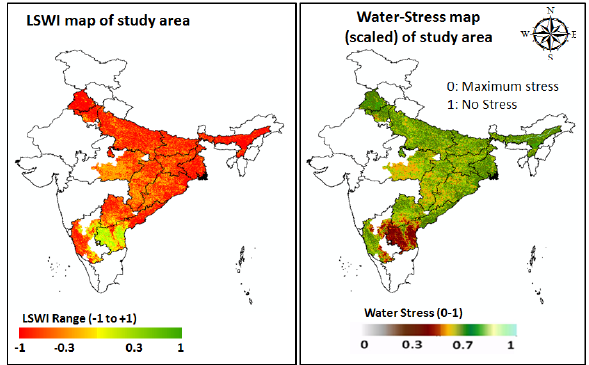
Figure 5: LSWI & Water Stress map of study area during 13-20 Aug, 2018 (1: No stress; 0: Maximum stress) Average temperature stress over a period of 8 days in a scale of 0-1 was derived from the average interpolated temperature depicted in Figure 6. For the whole crop period the